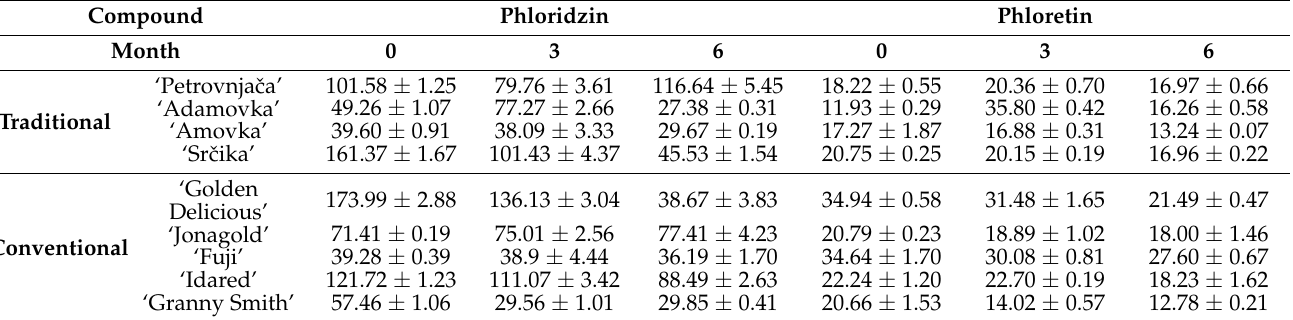
Table 3. The content of dihydrochalcones ( µ g/g dw a ) in the traditional and conventional apple